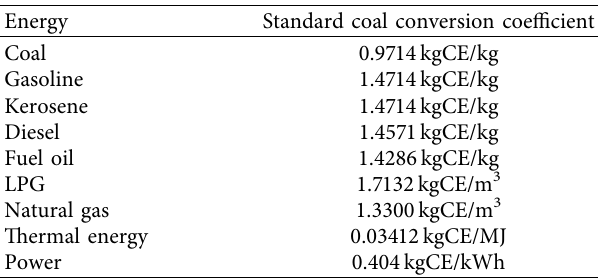
Table 1: Standard coal conversion coefficients for main energy sources.